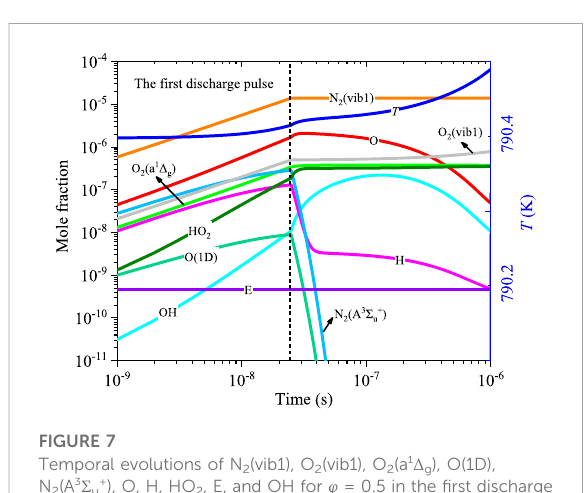
FIGURE 7 Temporal evolutions of N 2 (vib1), O 2 (vib1), O 2 (a 1 Δ g ), O(1D), N